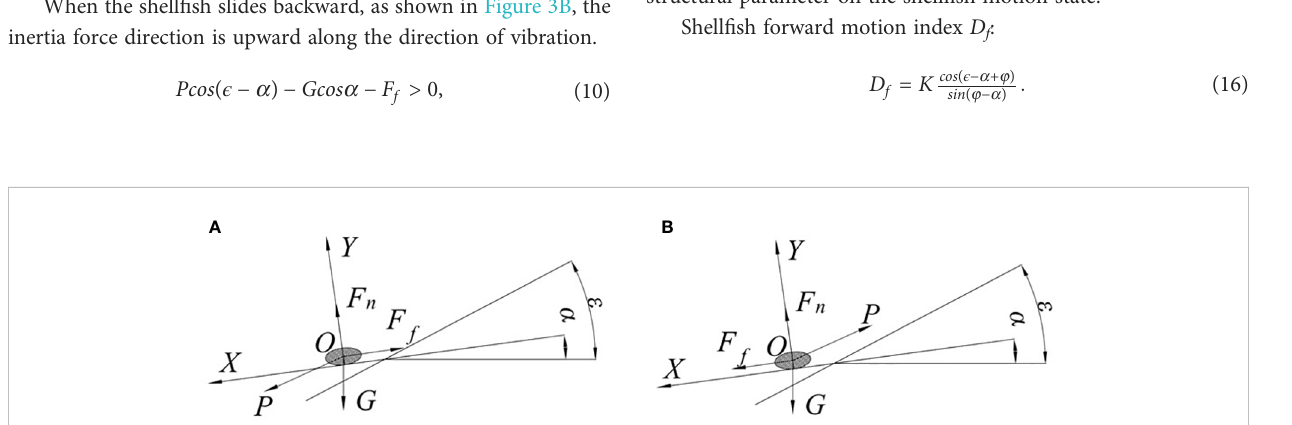
FIGURE 3 Force analysis of the shell fi sh motion state on the vibrating screen: (A) shell fi sh slides forward, (B) shell fi sh slides backward. The horizontal direction of the vibrating screen is set as the X-axis positive direction, while upward on the vertical screen surface is set as the Y-axis positive